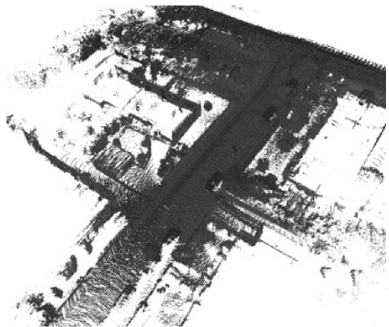
Figure 15. Point cloud mapping.